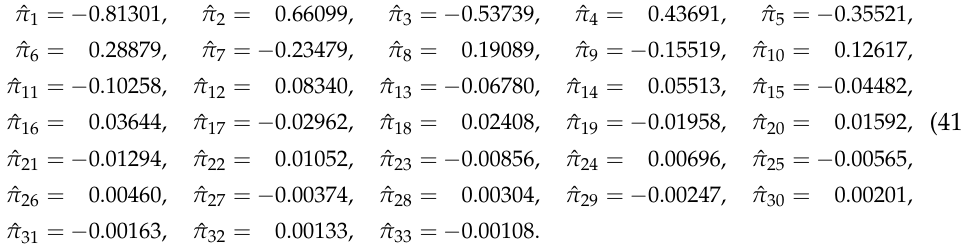
) for t = 1, . . . , 348 are drawn in Figure 4. We notice that the minimum ˆ x ∗ values of F n ( ˆ x ∗ t t